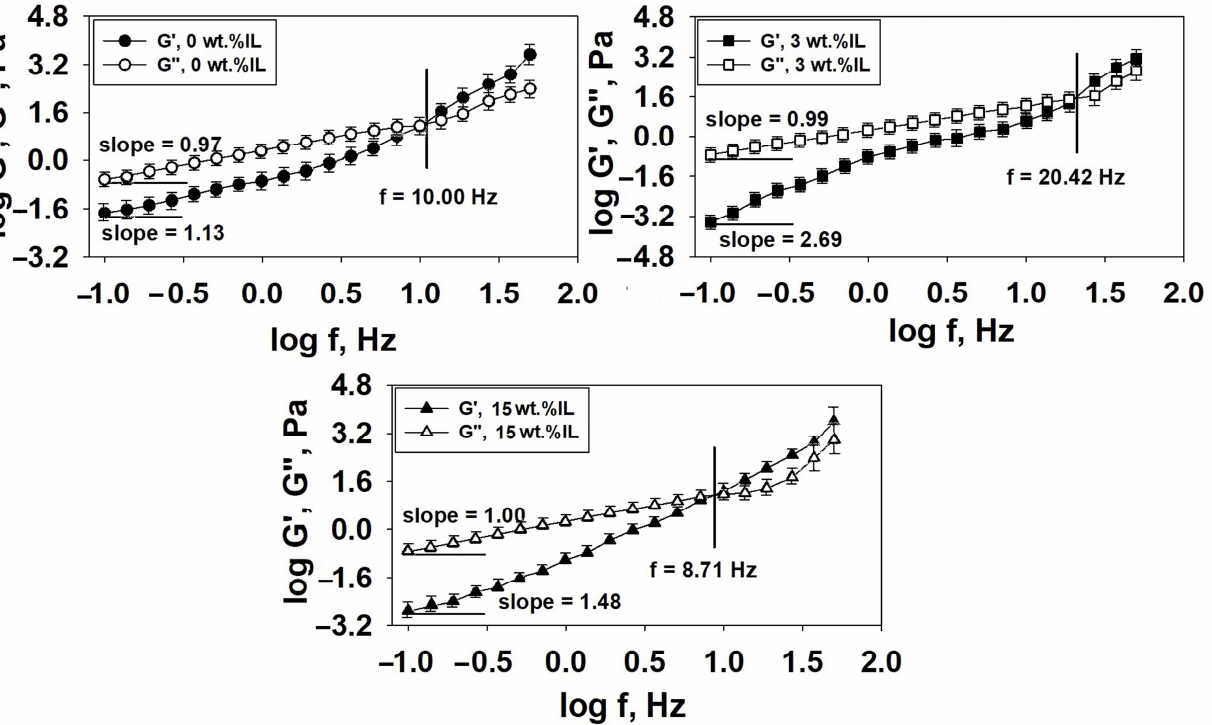
Figure 2. Logarithmic plot of storage (G’) and loss (G″) moduli versus frequency for the PSFQ/Am-IL 336 blend at different compositions.